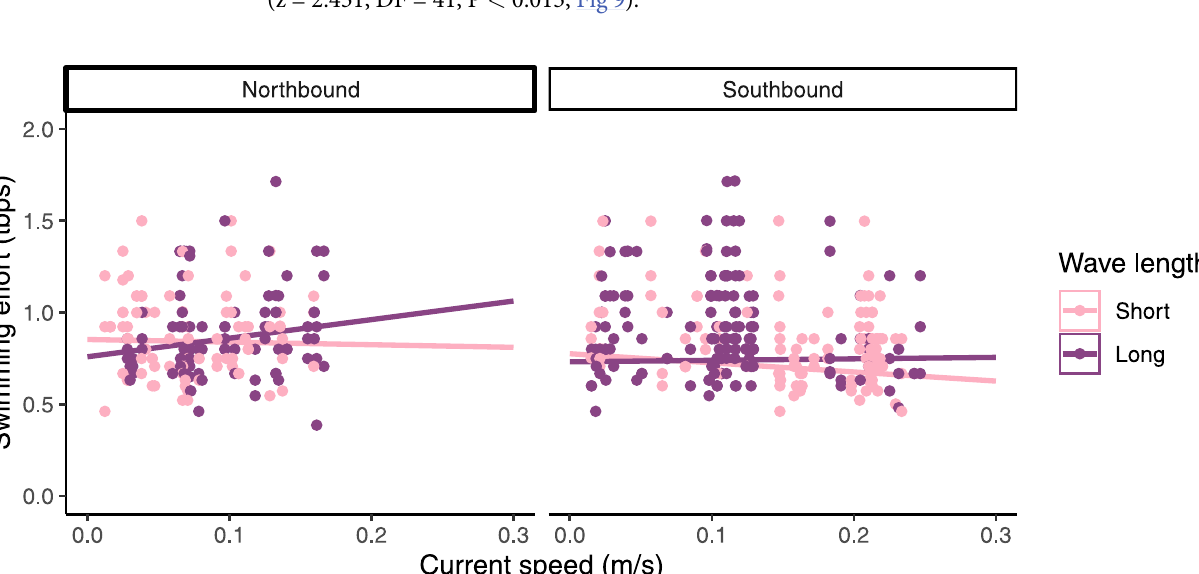
PLOS ONE | https://doi.org/10.1371/journal.pone.0263850 February 25,